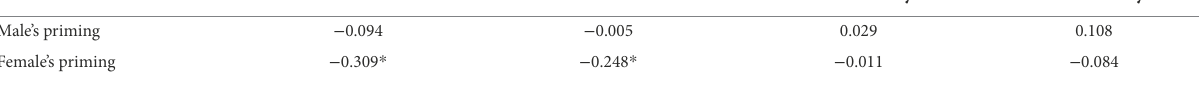
TABLE 7 Correlations between implicit mate preference and parents’ education level.